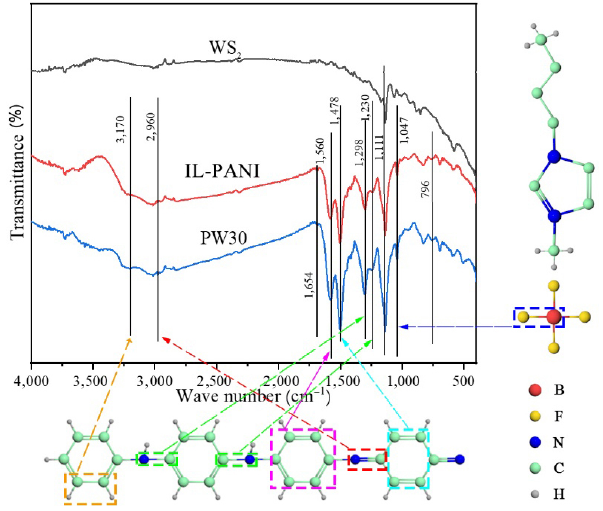
Fig. 2 Schematic of current-carrying friction test. Fig. 3 FTIR characterization of